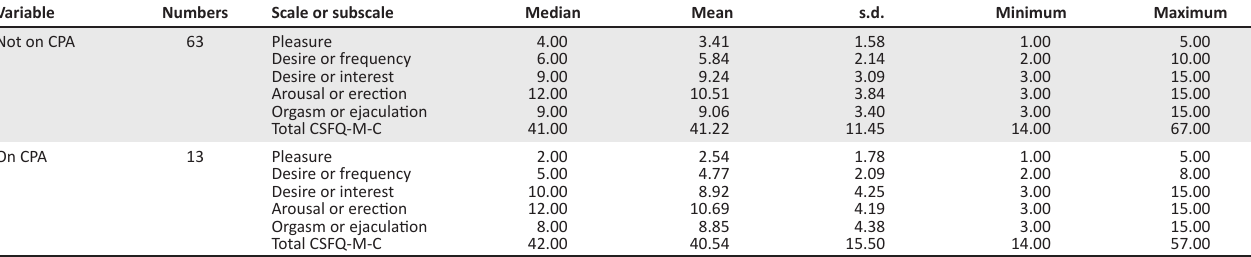
TABLE 2: Summary statistics of CSFQ-M-C total and subscale scores. Variable